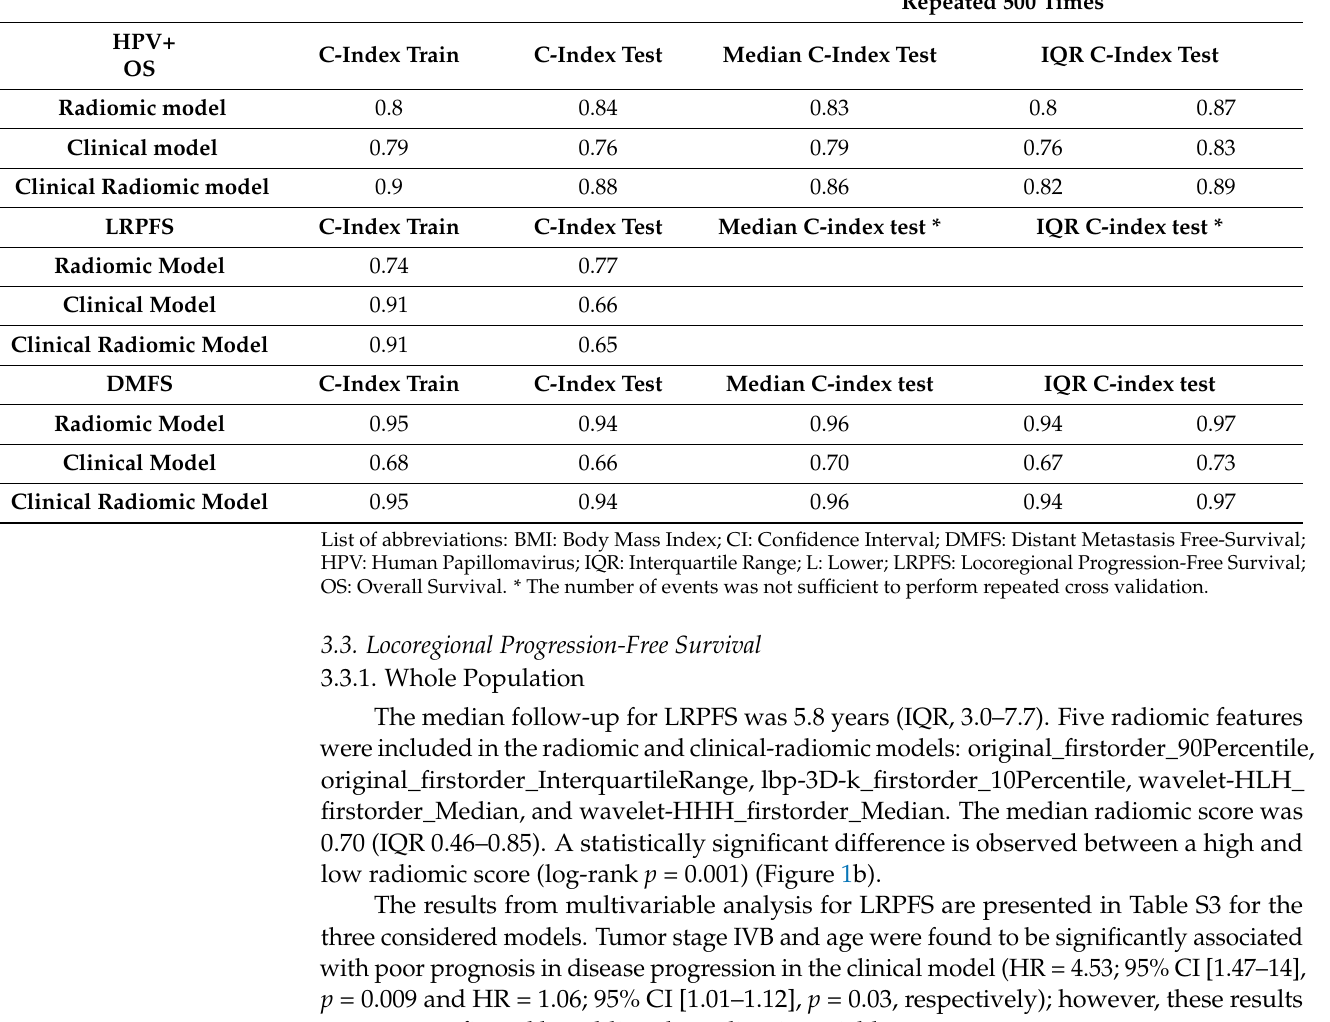
Table 4. Summary of the model performances for the HPV positive subgroup. 3-Folds